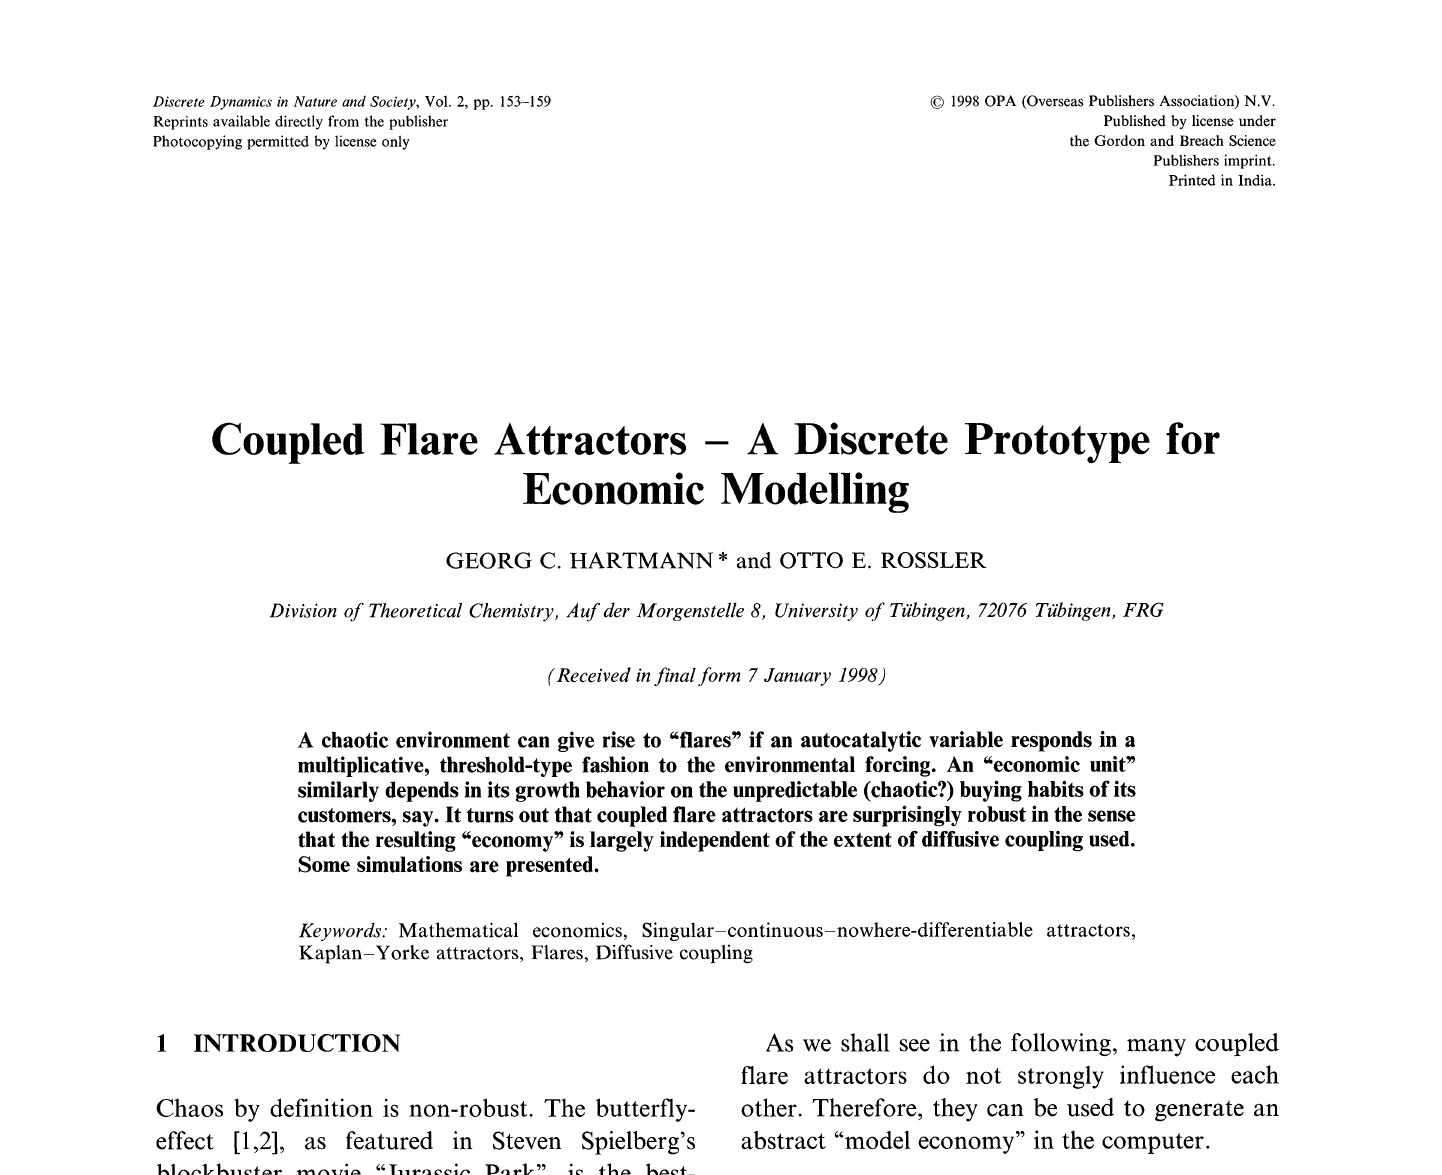
illustrates the principle. A corresponding discrete equation is, for